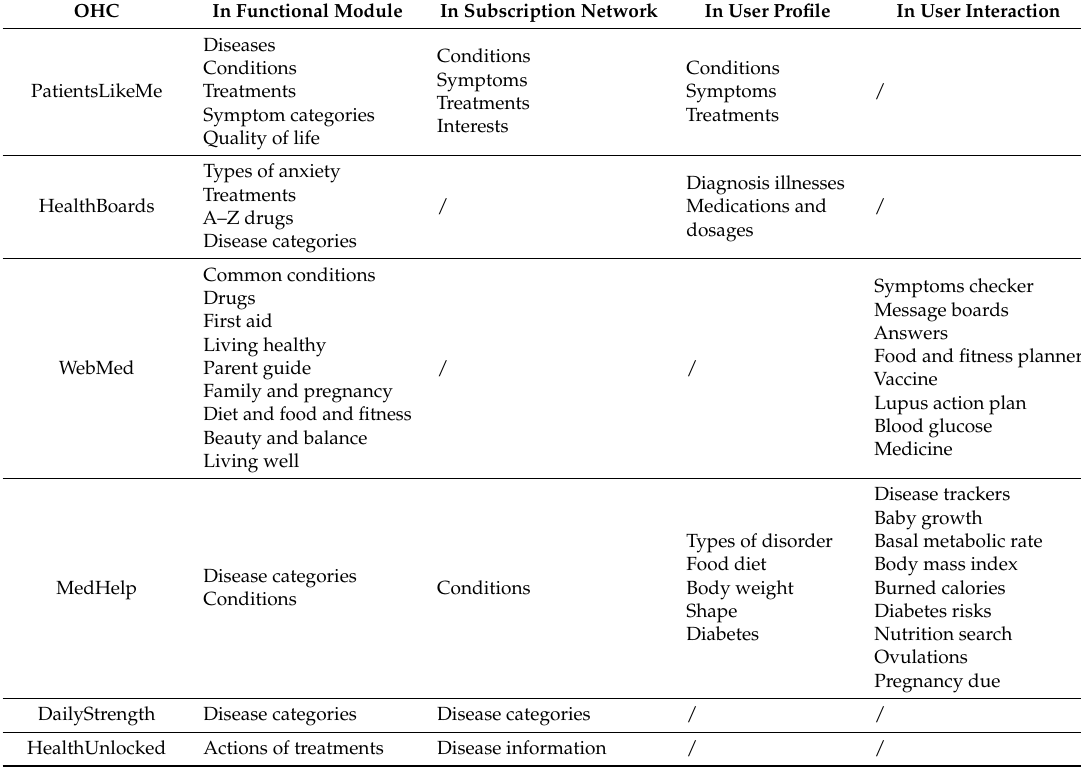
Table 1. Summary of the usage of health-care knowledge in six typical